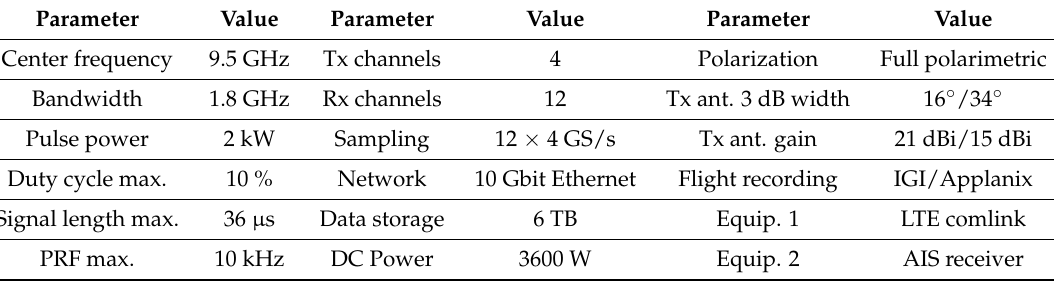
Figure 2. Block diagram of DBFSAR’s digital and X-band subsystems. Table 1. DBFSAR X-Band radar system